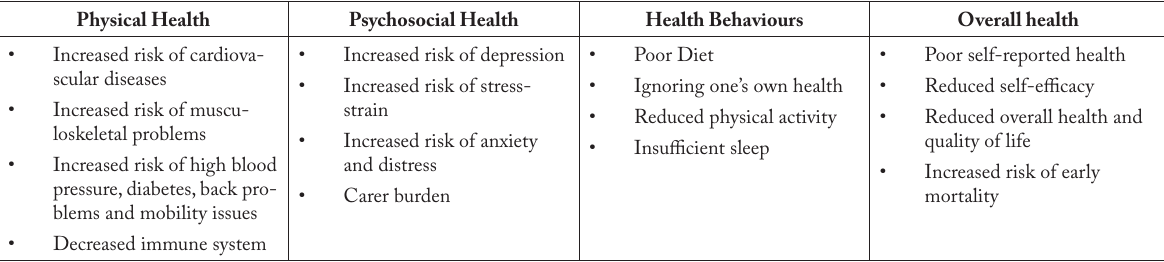
Table 1. Previously recognised health impacts of being a carer [1, 10, 13–16]- Table Adapted from